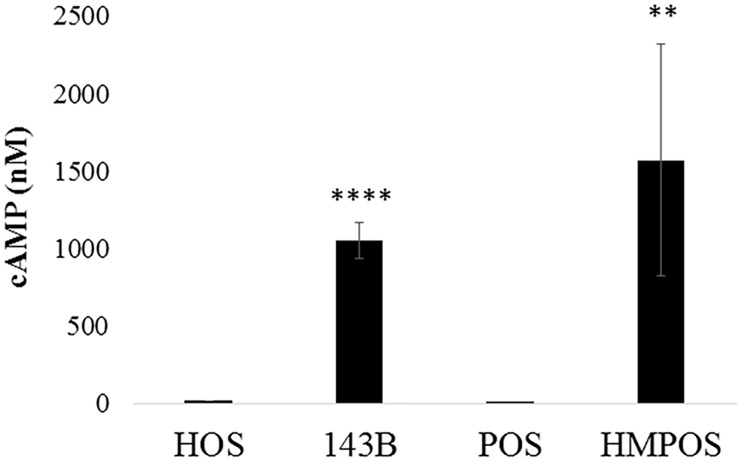
Fig shows the relative GPCR activity as measured by cAMP concentration.The experiment was performed in biological triplicates (and technical duplicates) with n = 2 (total separate trials). **** p <0.0001 and ** p<0.01.